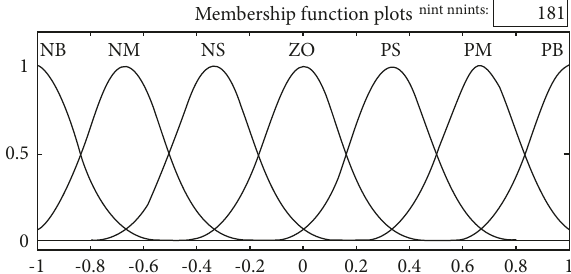
Figure 8: Output M Z membership function.